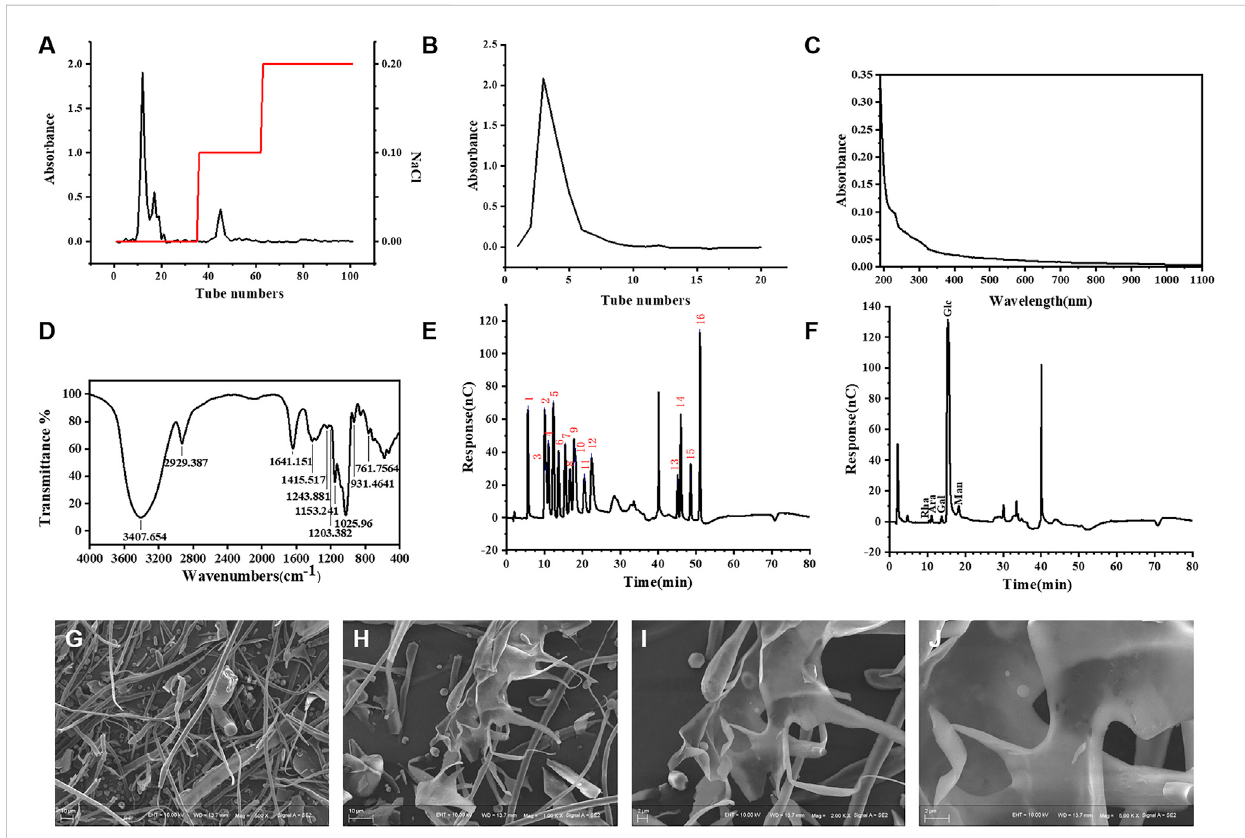
FIGURE 2 Structure characterization ofFNPS.Elution pro fi le ofFNPS on DEAE-52 cellulose column (A) and Sephadex G-100 column (B) . (C) UV – visspectrum of FNPS. (D) Infrared spectra analysis of FNPS. Ion chromatogram of sixteen mixed standards (E) and FNPS (F) . Magni fi cation: (G) ×500; (H) ×1000; (I) ×2000; (J)